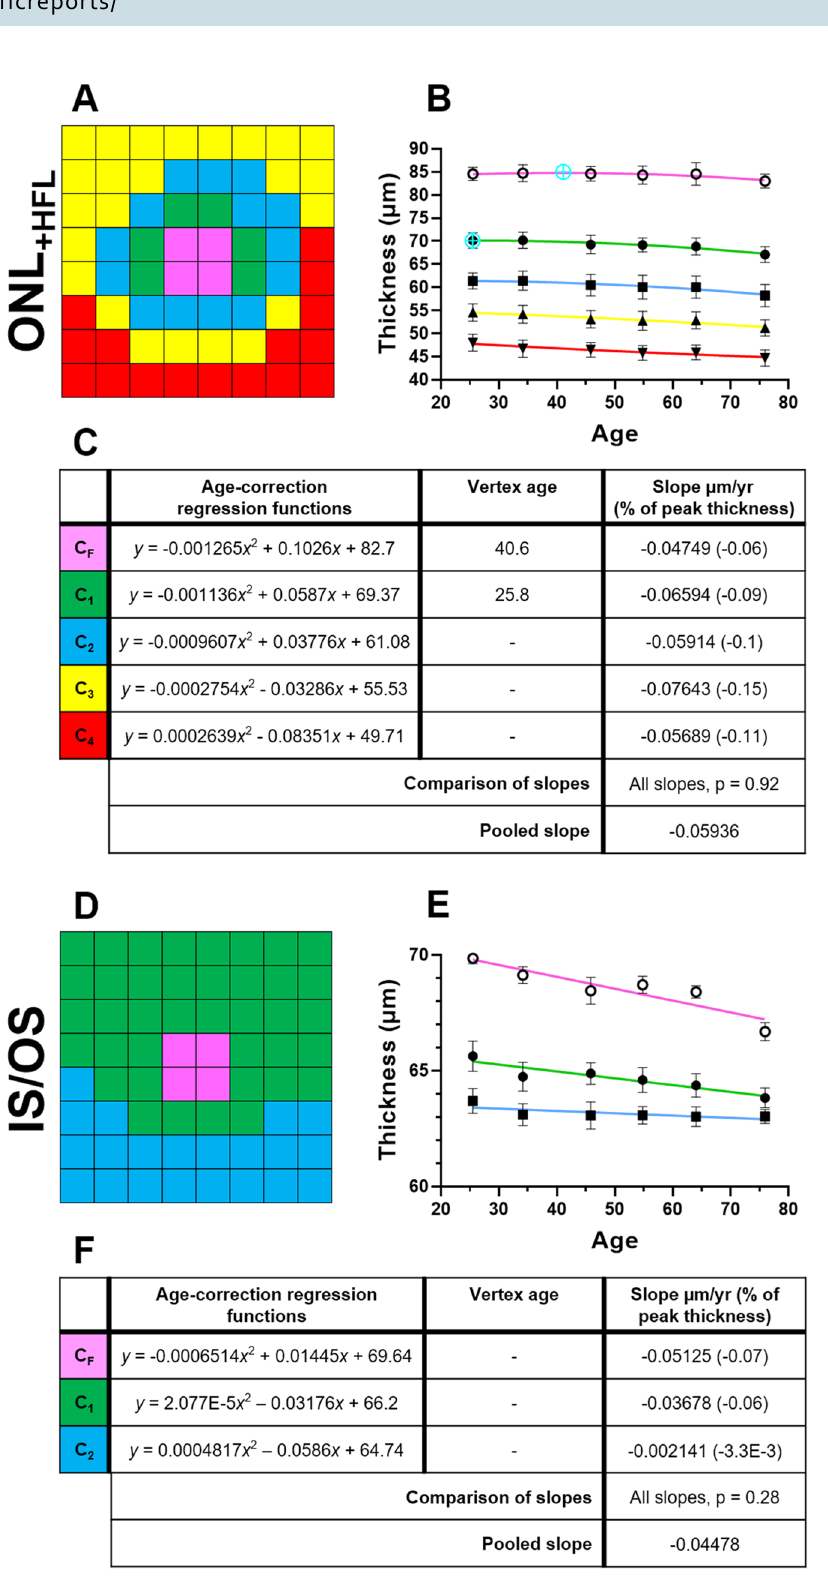
Figure 4. Spatial topography and age-related regression analysis where relevant in the ( A – C ) outer nuclear layer with Henle’s fibre layer (ONL +HFL ), ( D – F ) photoreceptor inner-segment and outer-segment layer (IS/OS), and ( G – I ) retinal pigment epithelium (RPE), using location-specific cluster analysis. For each layer, the ( A , D , G ) spatial cluster patterns (in right eye format), ( B , E , H ) corresponding plots of cluster thickness versus groups, i.e. age interval cohorts or singular grouping using the whole cohort, and ( C , F ) corresponding age-correction regression functions, vertex ages), and slopes as derived after the vertex age are presented. All slopes were significantly different from zero ( p < 0.05). Presentation as in Fig.